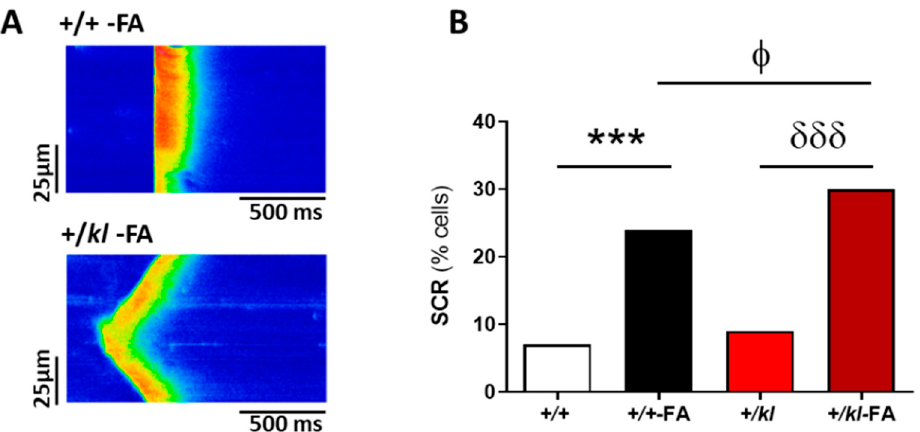
Figure 5. Partial klotho deficiency in AKI conditions augmented the incidence of SCR. ( A ) Repre- sentative images of ventricular cardiomyocytes with SCR in the form of an automatic transient (up- per panel) or a wave (lower panel) of Ca 2+ from mice after induction of AKI. ( B ) Percentage of cells that exhibited SCR as the sum of spontaneous Ca 2+ waves and transients in +/+ (n = 53 cells, N = 5 mice), +/+-FA (n = 82 cells, N = 4 mice), +/ kl (n = 51 cells, N = 5 mice) and +/ kl -FA animals (n = 64 cells, N = 3 mice). Data are expressed as a percentage. *** p < 0.001 vs. +/+, ϕ p < 0.05 vs. +/+-FA, δδδ p < 0.001 vs. +/ kl .